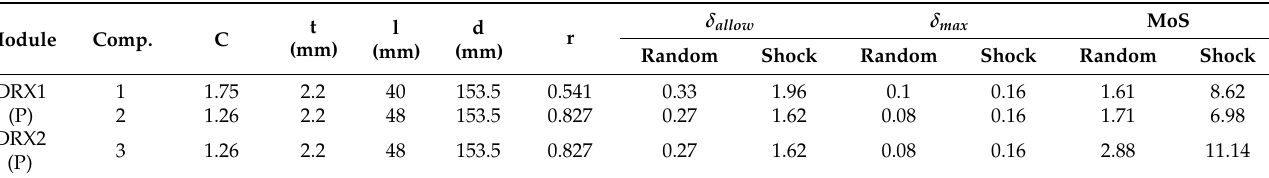
Table 6. Dynamic analysis results of DRX of HSDRU with minimum